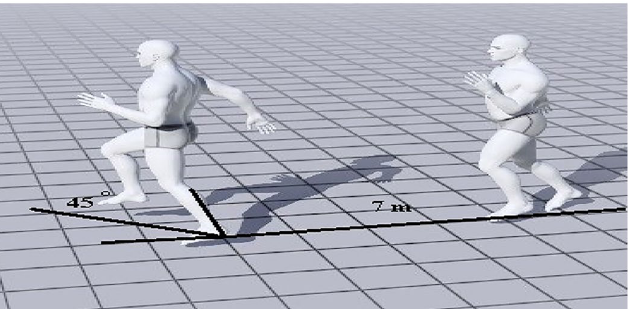
Figure 2. Cutting maneuver from the lateral view (Generated by Magic Poser software version: 1.56.1. https:// magic poser.